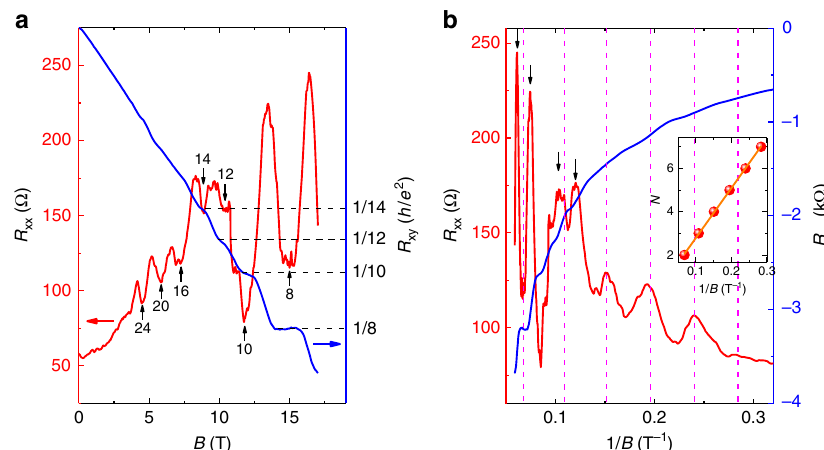
Fig. 3 Quantum Hall effect in Cd 3 As 2 nanoplate. a Magnetic fi eld dependence of R xx (blue) and R xy (red) in sample #7. b R xx (blue) and R xy (red) as a function of 1/ B . The red dash lines give the original LL positions assuming no splitting. The inset is the corresponding Landau fan diagram, which provides the LL index N for each oscillation peak